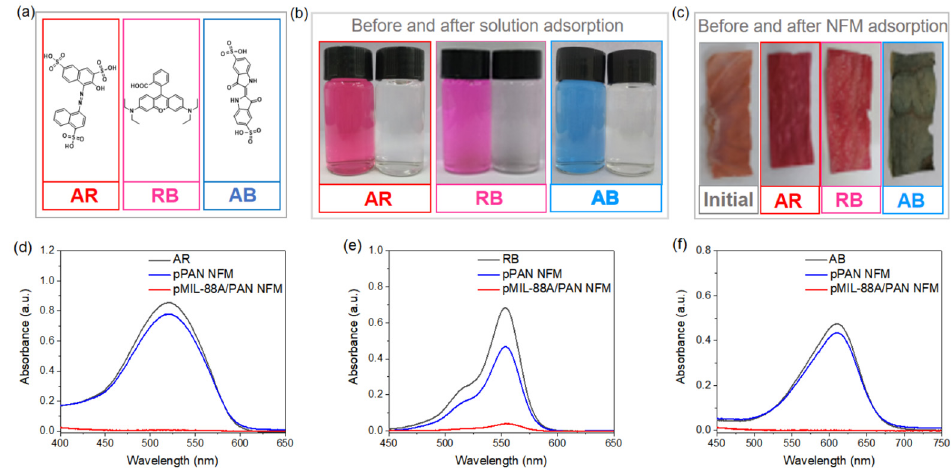
Figure 4. ( a ) Chemical structures of AR, RB, and AB. ( b ) Photographs of dye solutions before and after adsorption. ( c ) Photographs of pMIL-88A/PAN NFMs before and after adsorption. UV − vis absorption spectra of AR ( d ), RB ( e ), and AB ( f ) solutions before and after adsorbed using pPAN and pMIL-88A/PAN NFMs.